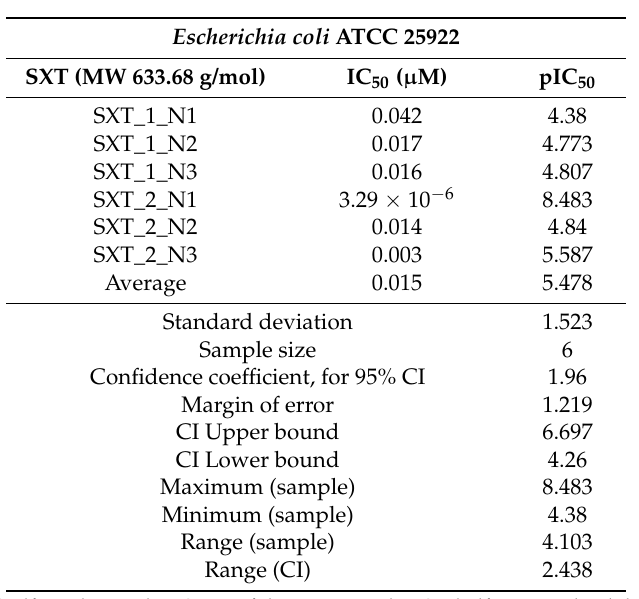
Table 1. IC 50 ( µ g/mL) and pIC 50 data (N1, N2, and N3) for two titrations of SXT (SXT_1 and SXT_2) on each run (N1, N2, and N3) of the secondary screen and their corresponding average, standard deviation, sample size, confidence coefficient for 95%CI, margin of error, CI upper bound, CI lower bound, maximum (sample), minimum (sample), and range (sample and